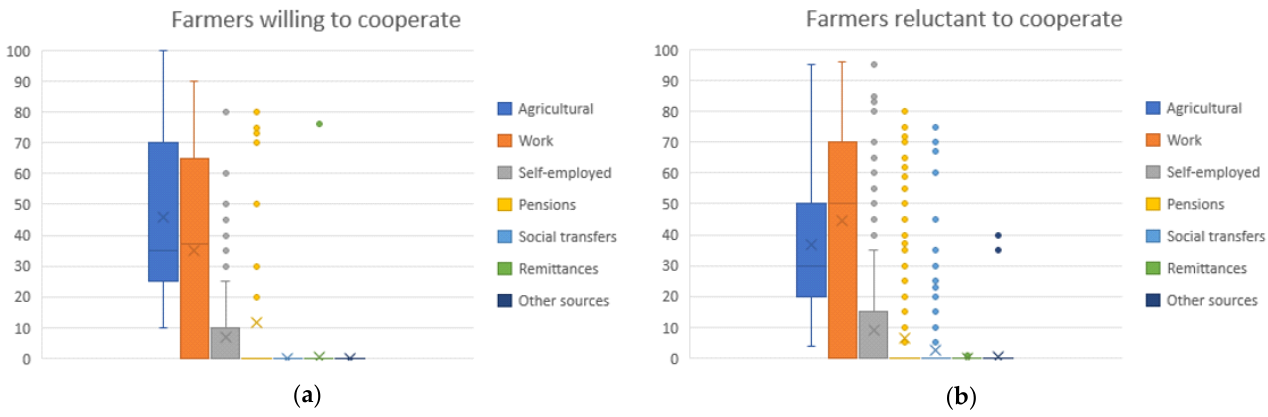
Figure 10. S mall-scale farm income structure in groups of small farm s willing to cooperate ( a ) and reluctant to cooperate Figure 10. Small-scale farm income structure in groups of small farms willing to cooperate ( a ) and reluctant to cooperate ( b ) (N = 1002). ( b ) (N =